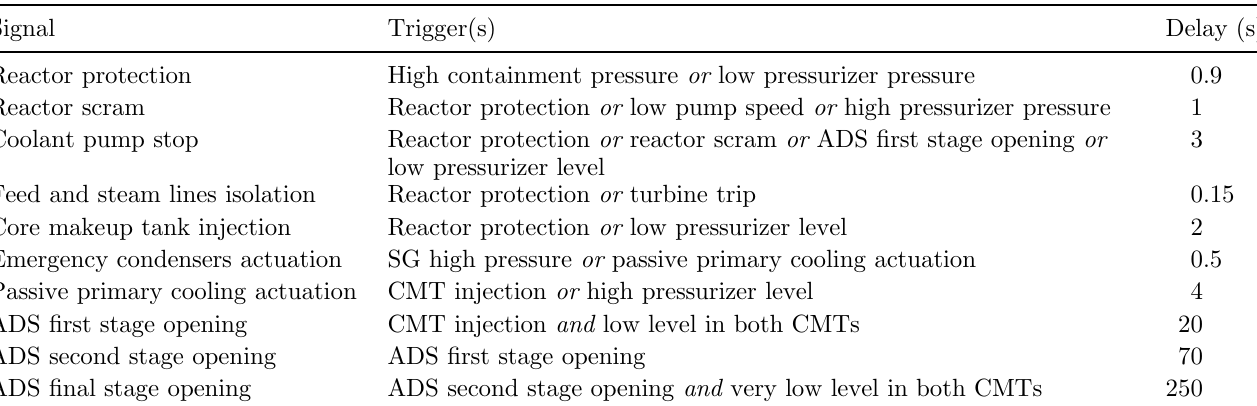
Table 3. Safety signals (conservative delays for actuation).